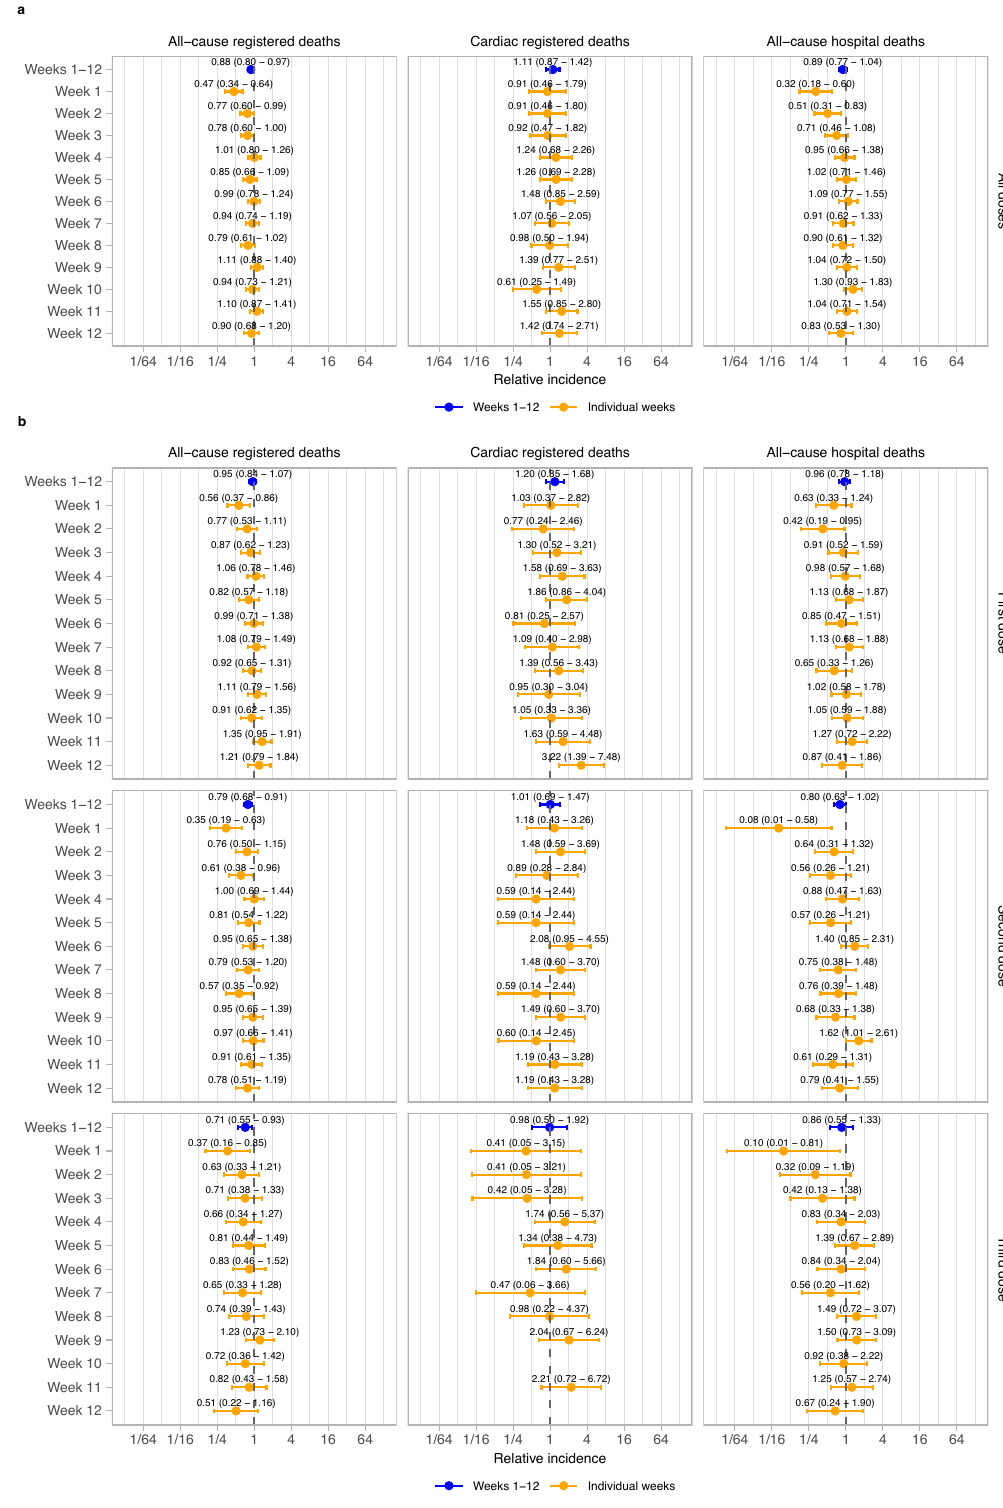
Fig. 1 | Relative incidence of cardiac death and all-cause death in each of the 12weeksintheriskperiodaftervaccinationandintheriskperiodasawhole(1- 12weeks),comparedtothebaselineperiod. Dataarepresentedasincidencerate ratio with 95%con fi denceintervals. Modelsare adjusted for calendartime; IRR not